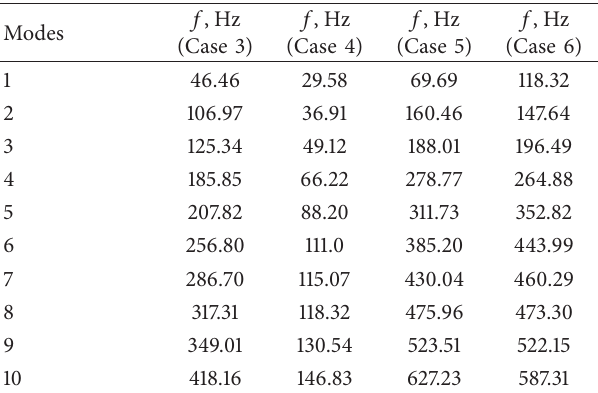
Table 5: First 10 natural frequencies for the isotropic panels.